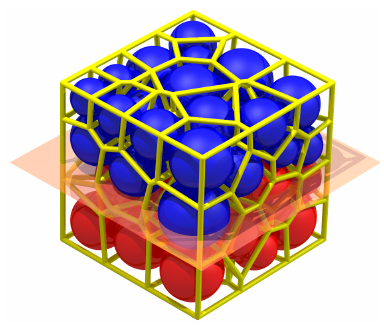
Figure 7. A typical spherical granular pack and its solid cell system.